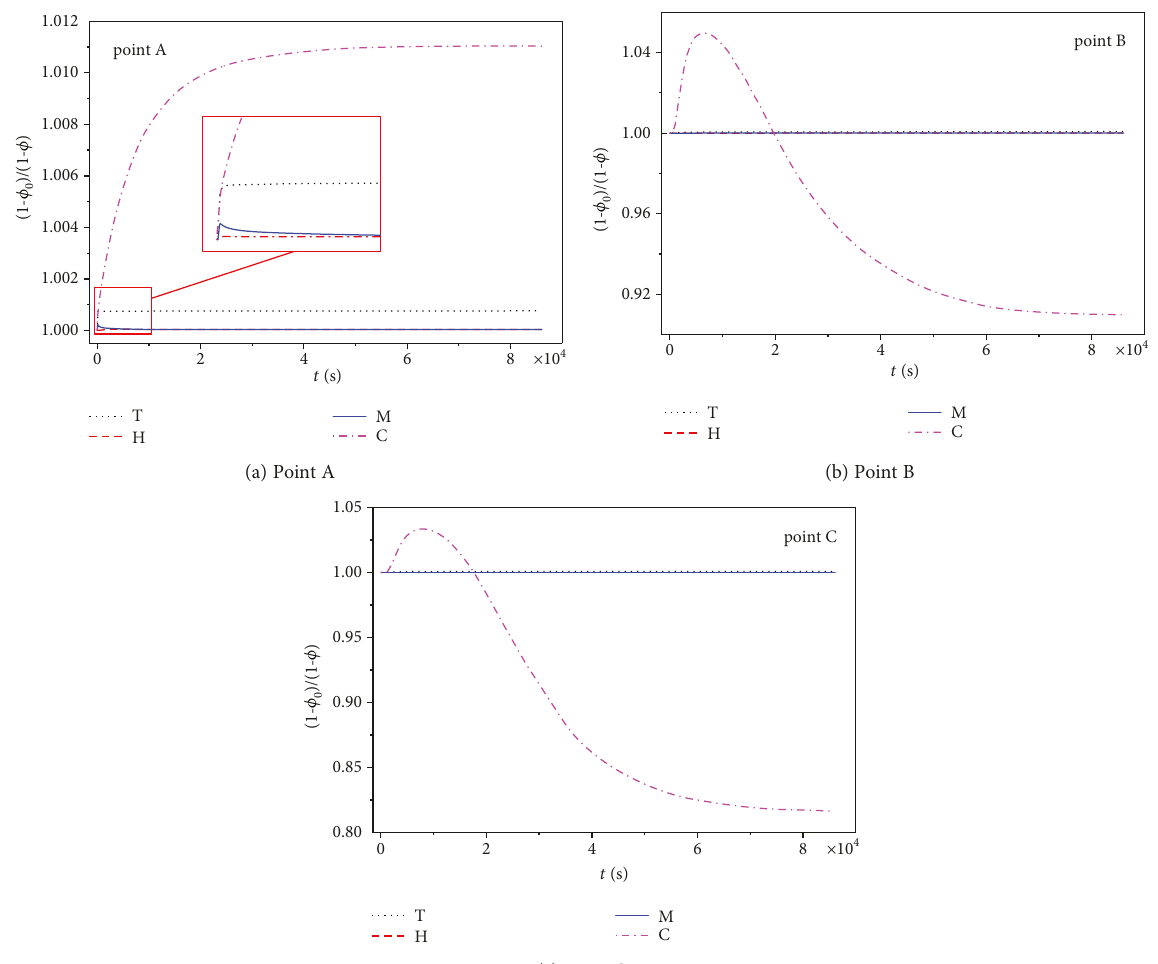
Figure 14: The in fl uence of component T-H-M-C processes individually on the evolution of